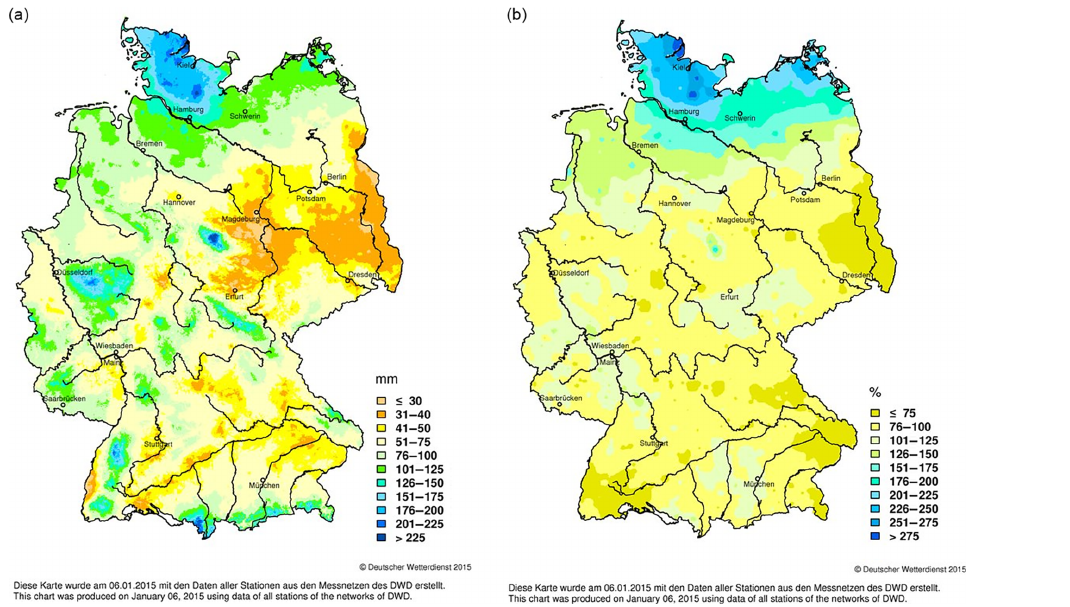
Figure 3. (a) Precipitation sums in Germany in millimetres, December 2014, and (b) their differences in percent to the long-term mean of 1961–1990. Image credit: DWD, www.dwd.de (last access: 6 January